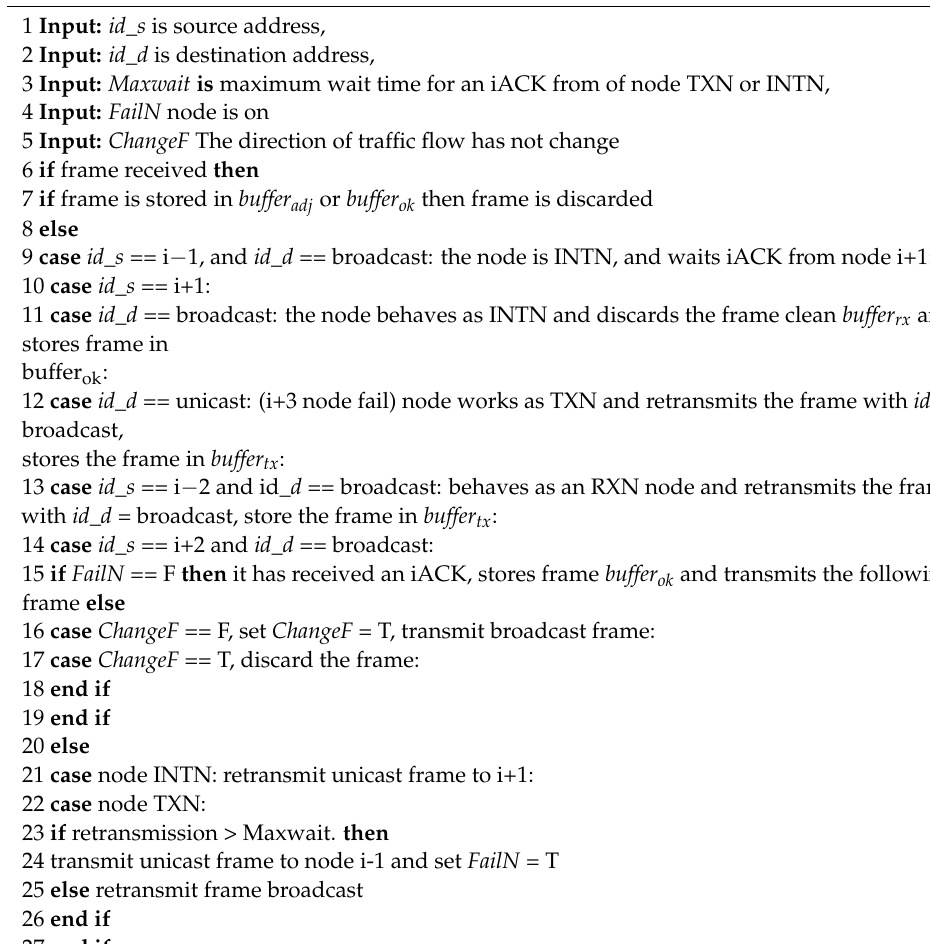
Figures 10–12 also show the state diagram for nodes TXN, RXN, and INTN.